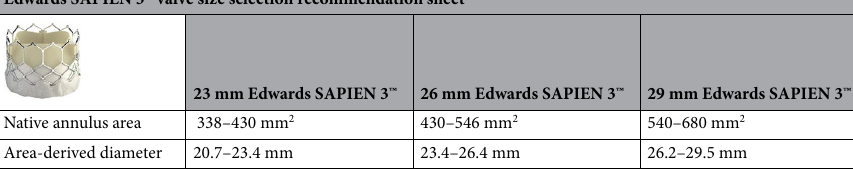
Table 2. Size selection sheet for Edwards SAPIEN 3™, image source: “With the kind permission of Edwards Lifesciences”.